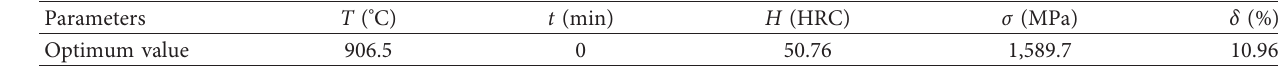
Table 11: Global optimum values.